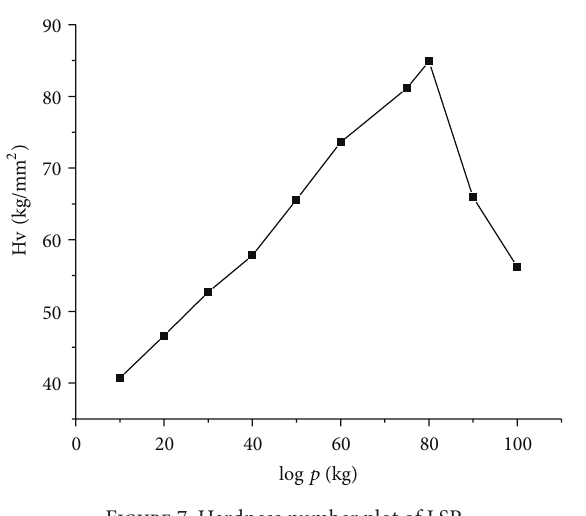
Figure 7: Hardness number plot of LSP.